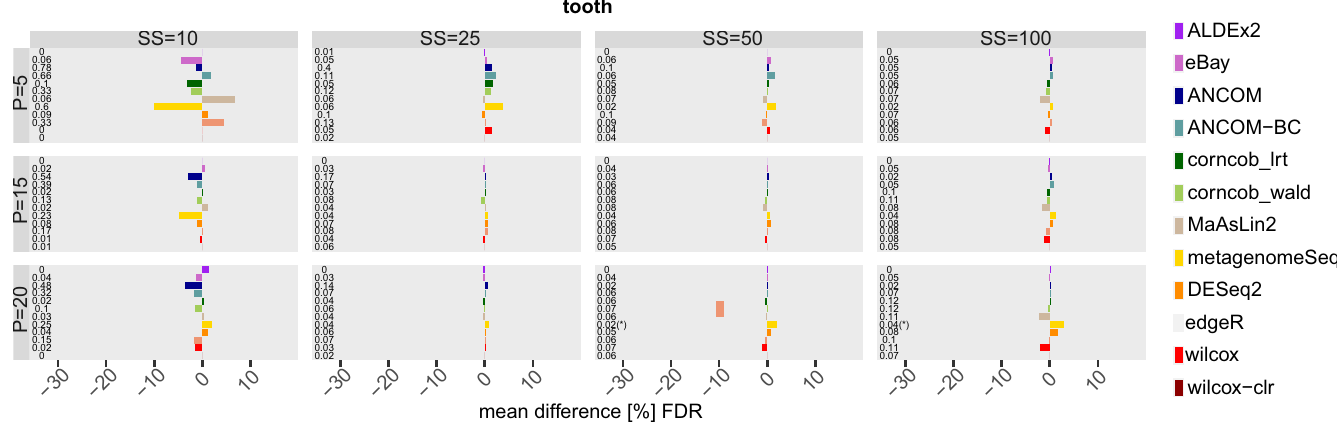
Fig 10. Mean FDR difference [%] between each differential abundance method and its GMPR normalised version for tooth dataset in the scenario with simulated DA features. Different percentages (P) of simulated DA features are on rows, while different sample size (SS) values are on columns. Numbers at the beginning of each row correspond to the FDR values obtained with default normalization, while the symbol ( � ) identifies that the Wilcoxon unpaired statistical test is significant.